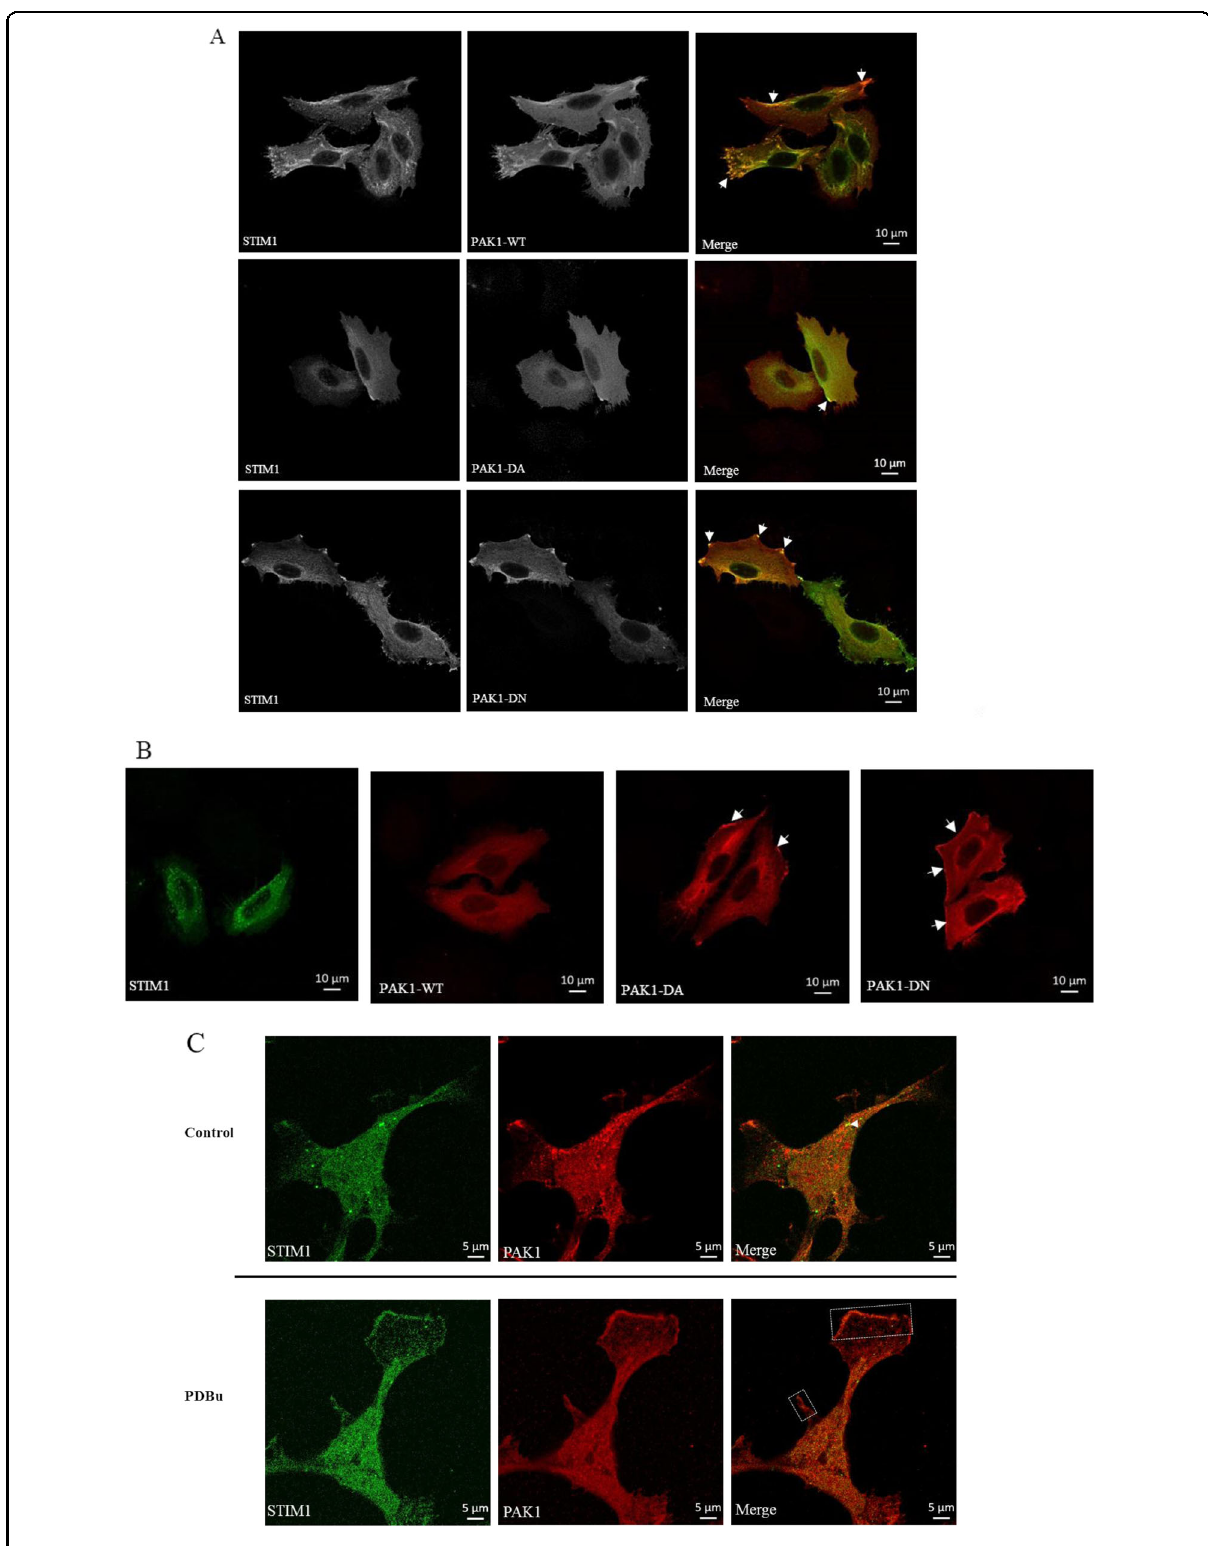
Fig. 2 (See legend on next